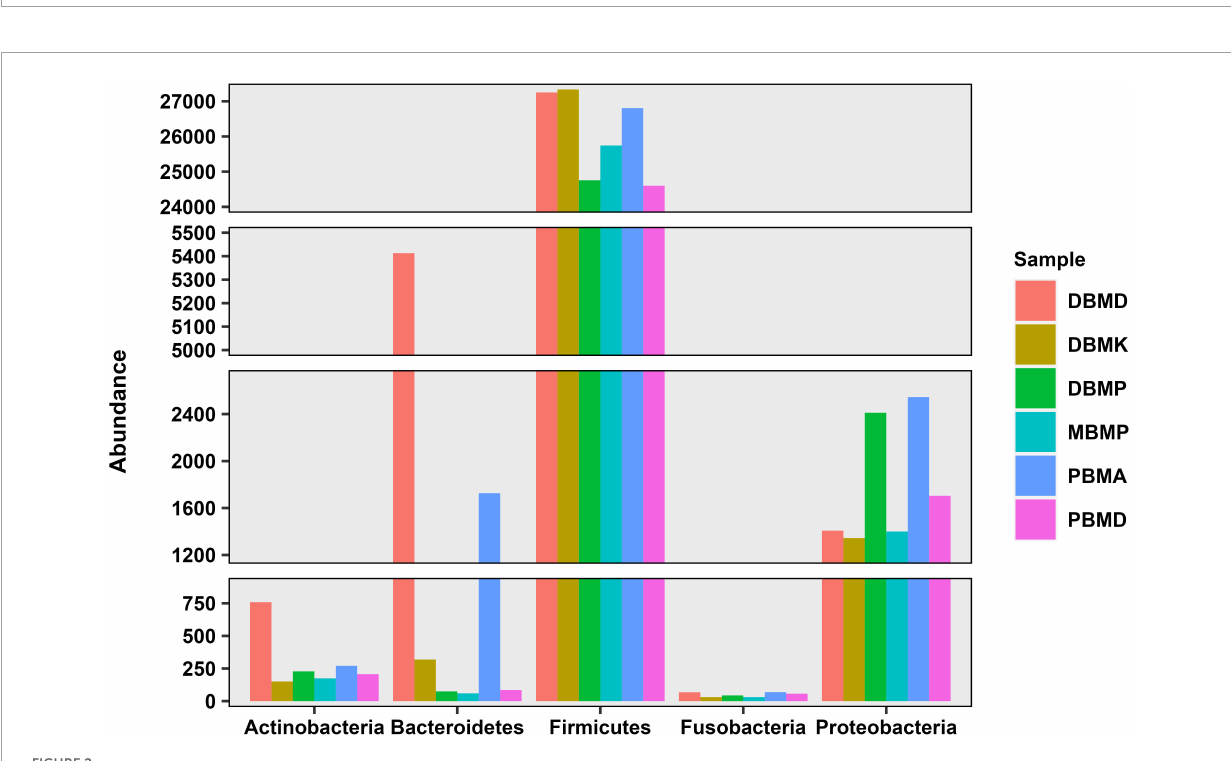
FIGURE2 Bar plot for major phylum in